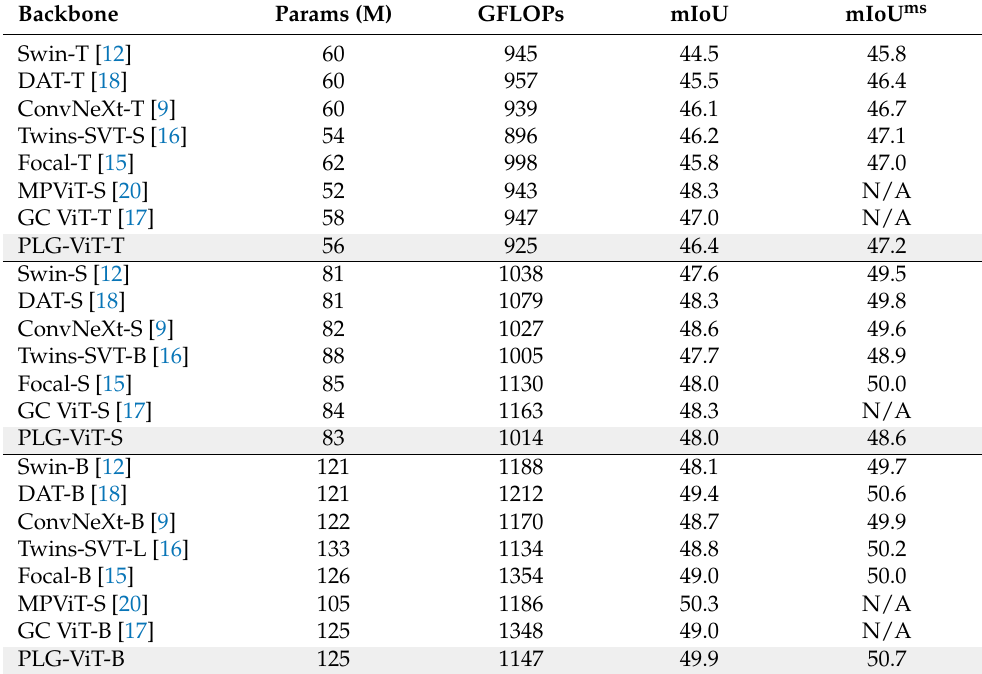
Table 4. Validation results for semantic segmentation with UPerNet [58] on the ADE20K val-set [41]. GFLOPS were calculated using images of size (2048, 512). The last two columns show single- and multi-scale (ms) evaluations of the mIoU. Our networks are highlighted in gray. All values are taken from the official